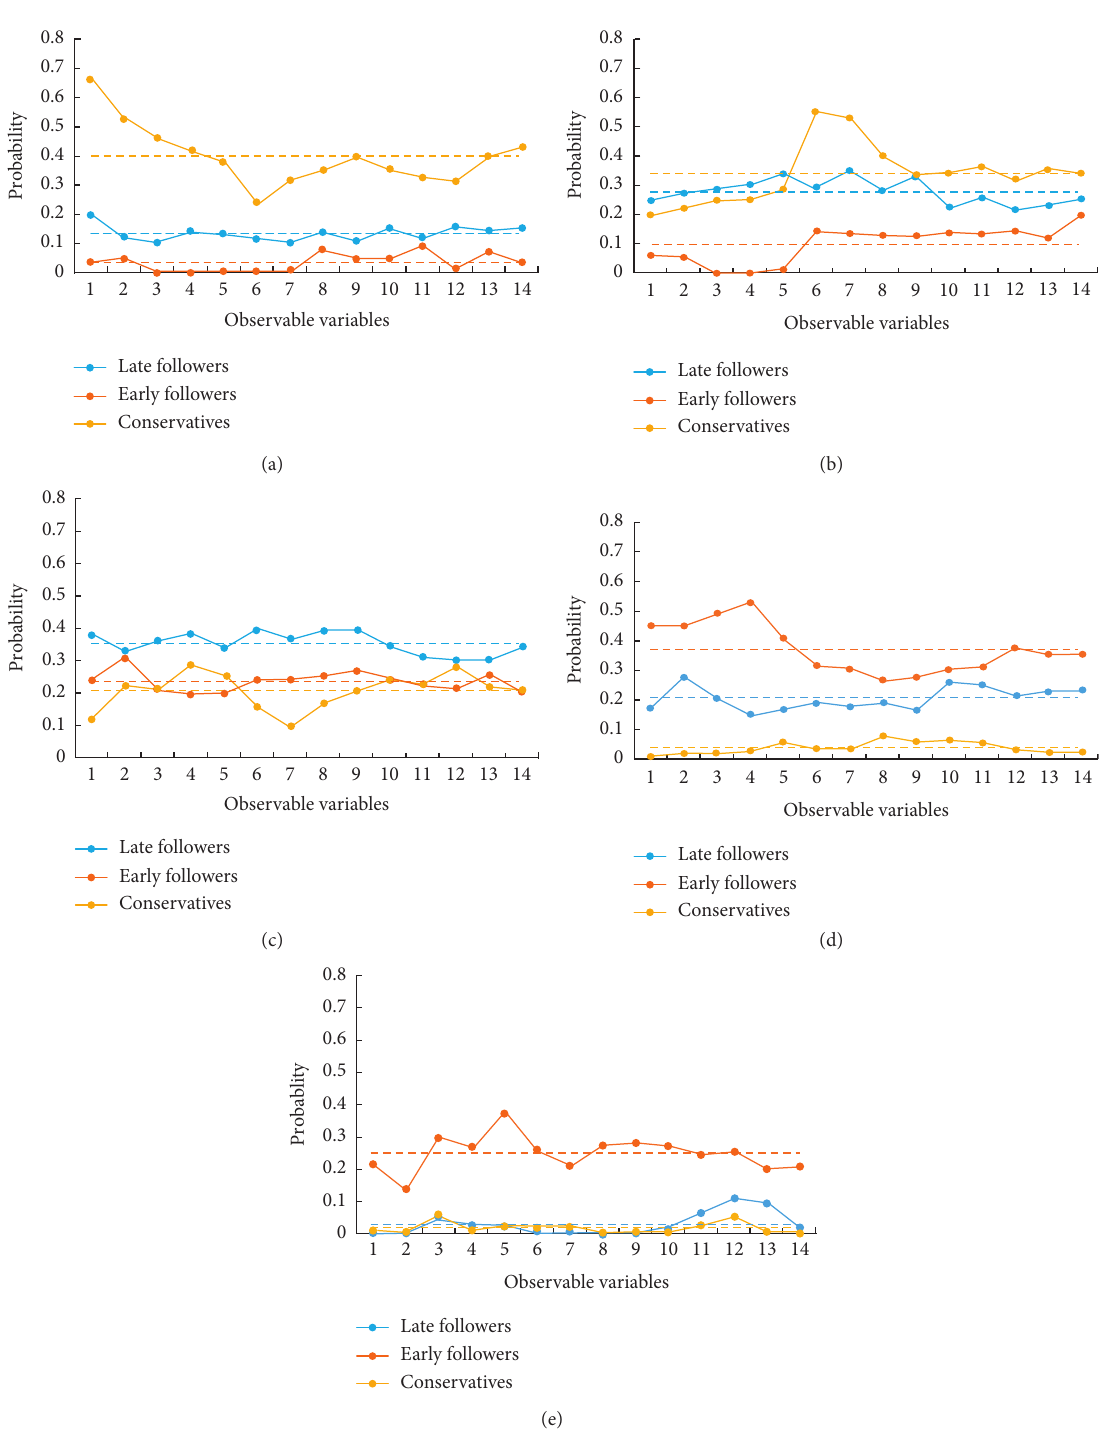
Figure 3: Conditional probability of LCA based on the data of 2015. (a) Strongly disagree. (b) Disagree. (c) Neither agree nor disagree. (d) Agree. (e) Strongly